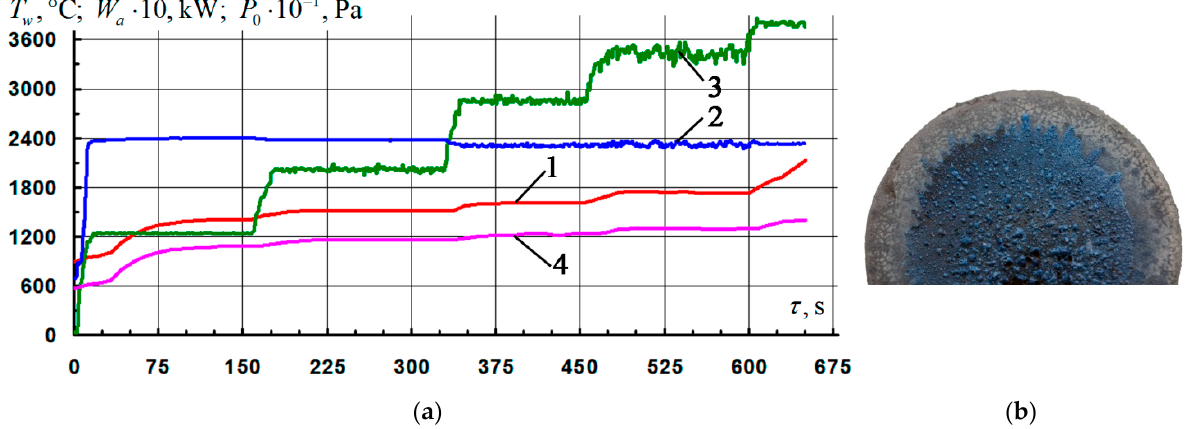
Figure 6. Results of gas-dynamic tests of C f /C–SiC samples with a base coating of the Si–TiSi 2 –MoSi 2 –TiB 2 system at T w ~ 1800 °C: ( a ) change of mode parameters in time: 1, 4—temperature of the front/back surface of the sample at the critical point, T w ; 2—generator power, W a ; 3—braking pressure in the pre-chamber of the heater, P 0 ; ( b ) typical view of the front side of the samples after testing.